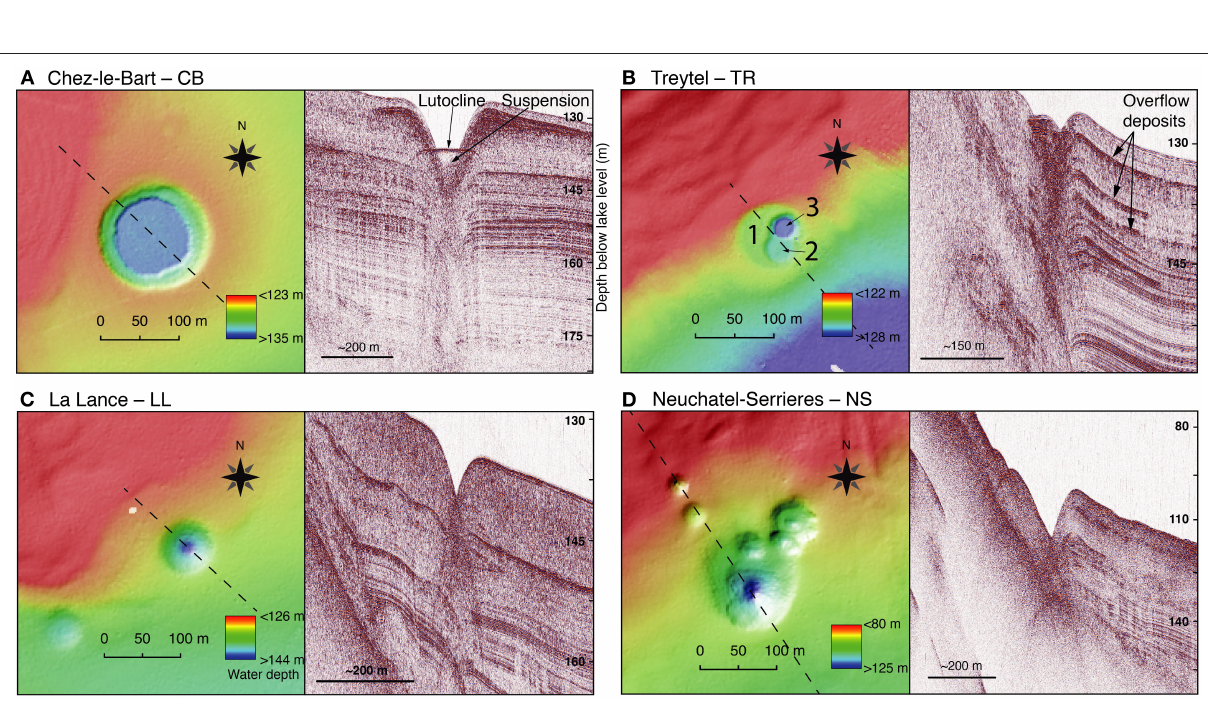
Frontiers in Water | www.frontiersin.org